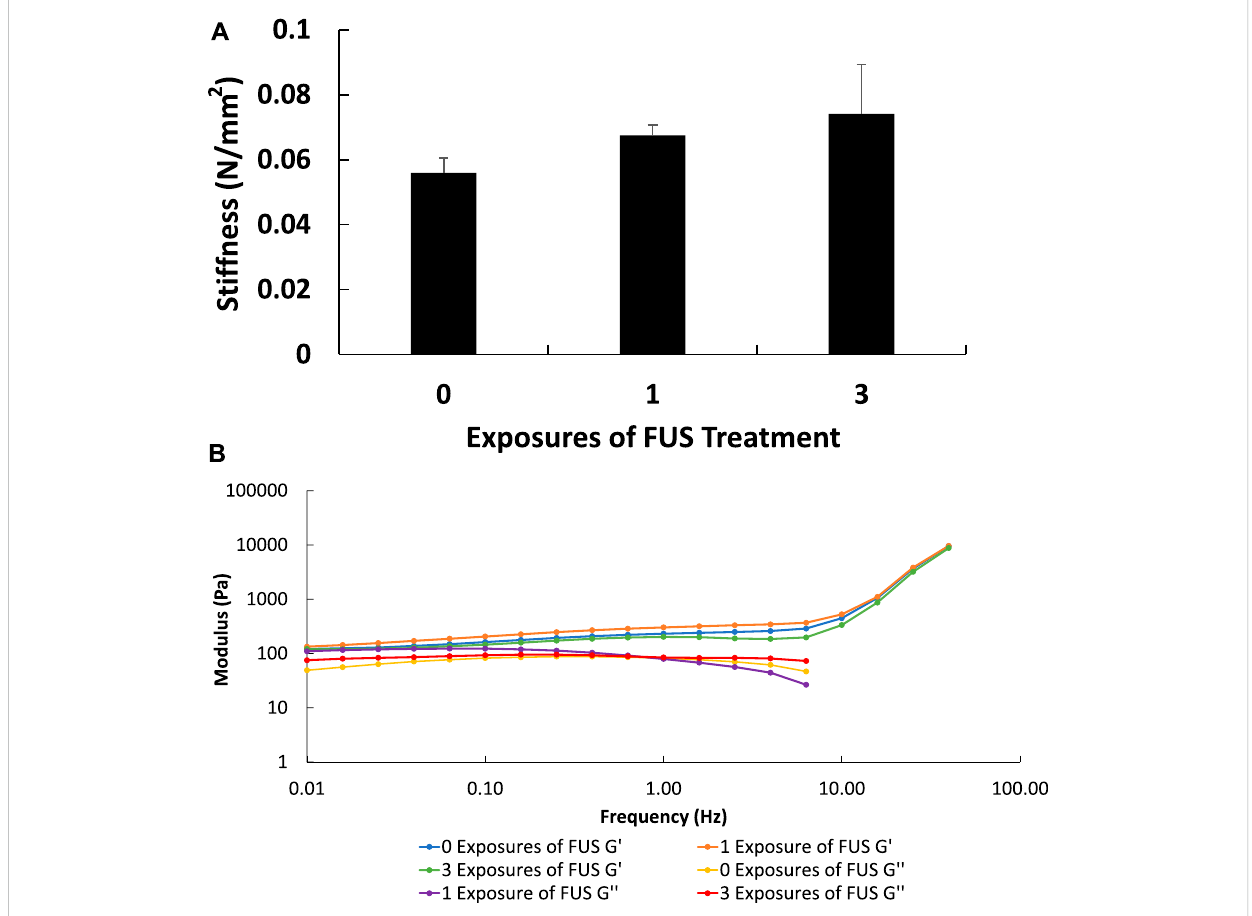
FIGURE 15 Indentation testing showed no signi fi cant differences in hydrogel stiffness among samples treated with 0, 1, and 3 exposures of 40 ° C FUS treatment for 5 min (n = 3) ( p < 0.05) (A) . Representative rheometry results showed that there were no differences in storage and loss modulus measurements among samples treated with 0, 1, and 3 exposures of 40 ° C FUS treatment for 5 min (B)